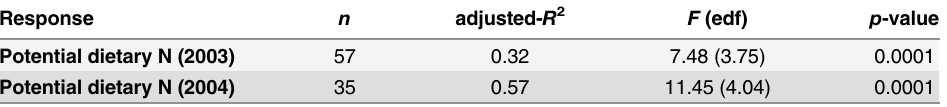
Table 2. Generalised Additive Modelling (GAM) results, where potential dietary N of Pyrenean Rock Ptarmigan recorded in 2003 and 2004 are the response variables and snowmelt time is the predictor.